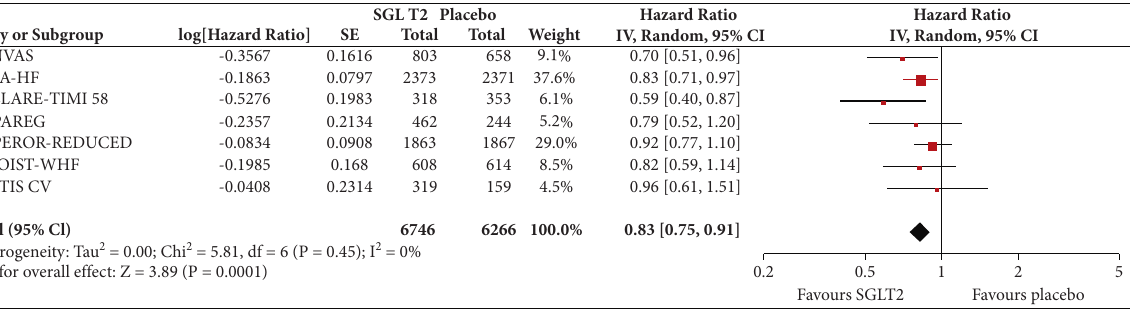
Figure 1: Effect of SGLT2 inhibitors versus placebo on all-cause mortality for the total